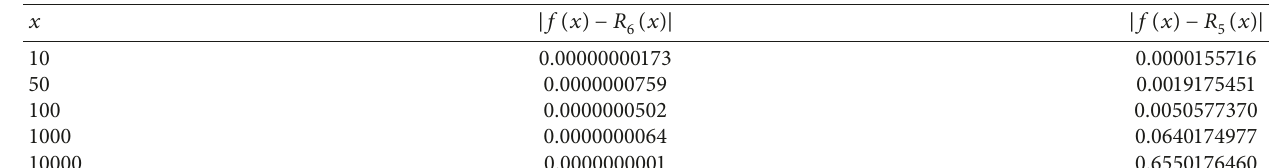
Figure 3: Function plots of f ( x ) and R Table 4: Numerical experiments about the error.